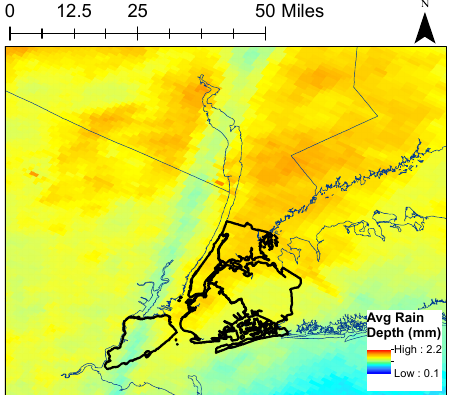
Figure 3. Daily averaged radar rainfall for all days in the warm seasons of 2001–2015. Navy lines are state outlines and black lines are NYC borough